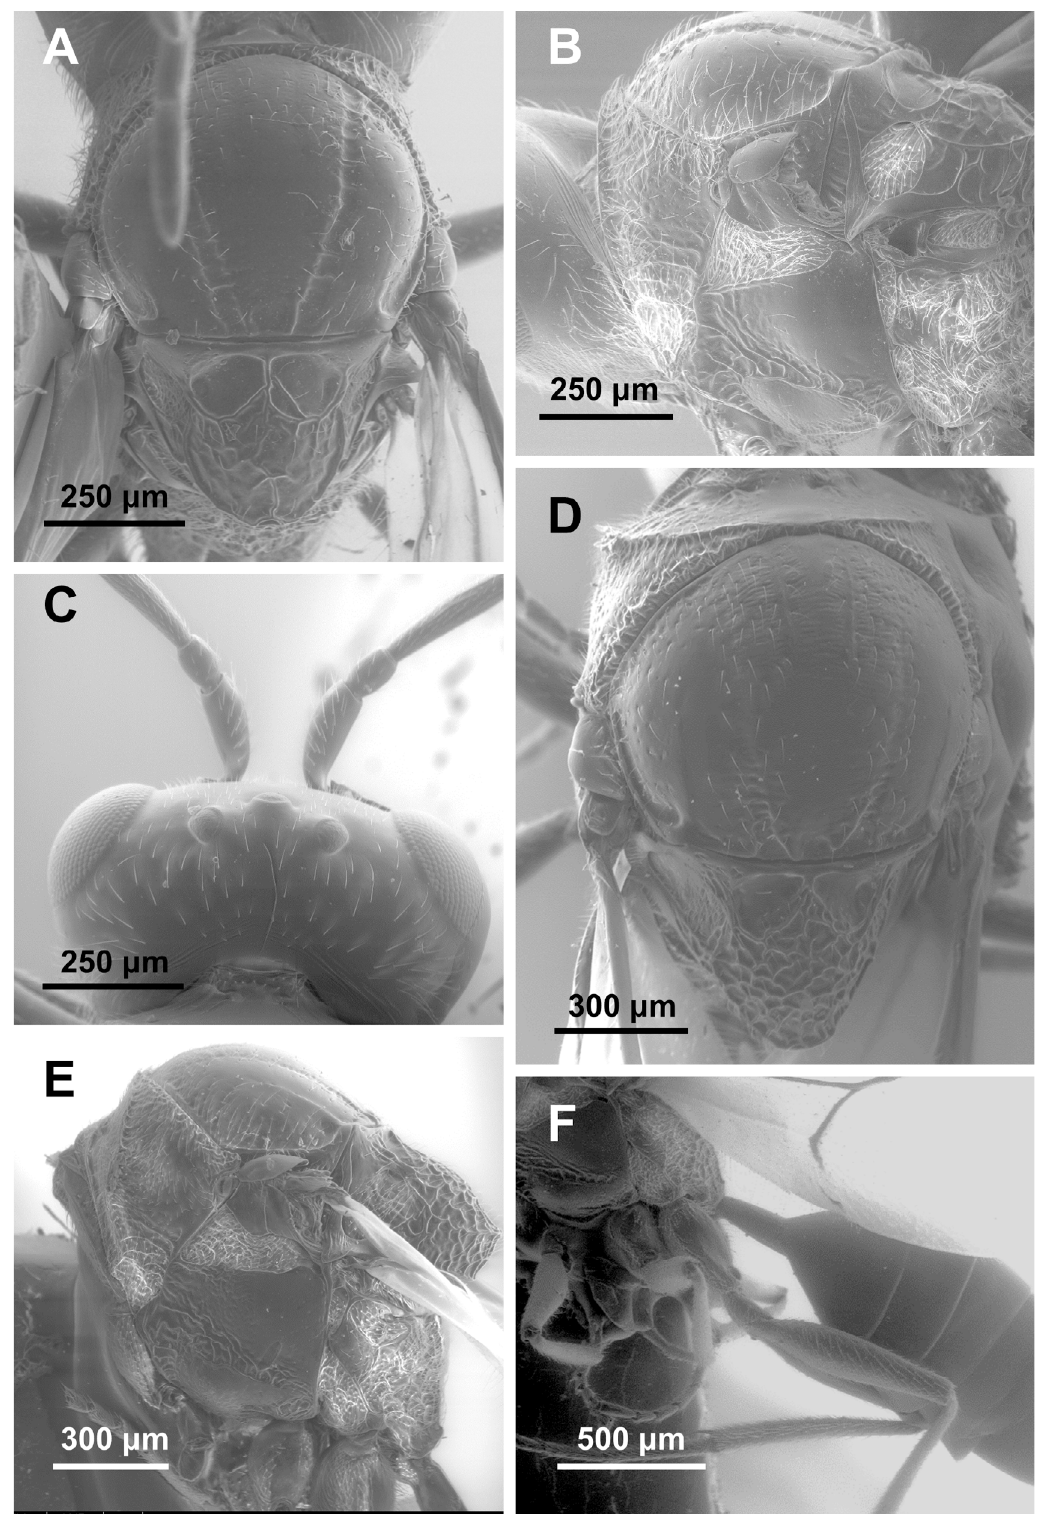
Fig. 4. Anacharis fergussoni sp. nov. A . Mesosoma in dorsal view. B . Mesosoma in lateral view. C . Head in dorsal view. – Anacharis norvegica sp. nov. D . Mesosoma in dorsal view. E . Mesosoma in lateral view. F .